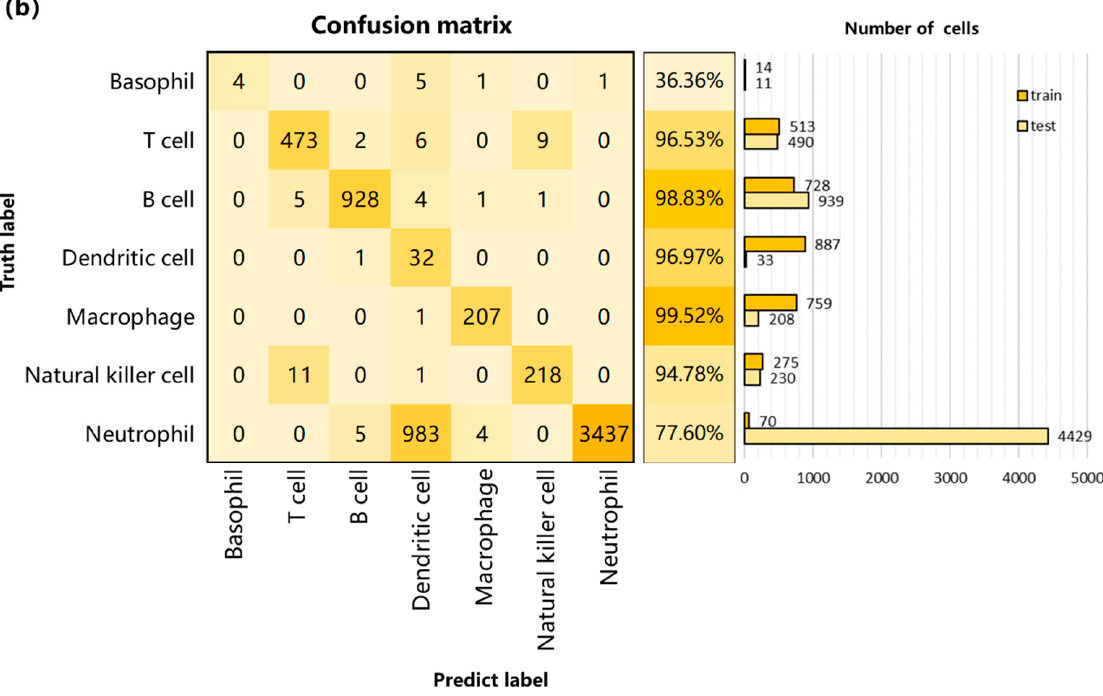
Figure 6. Confusion matrix of prediction results on external test datasets. ( a ) Confusion matrix for predicting results on the human lung dataset; ( b ) Confusion matrix for predicting results on the mouse lung dataset. The accuracies in the graphs represent the accuracies of the predicted results for each cell label. The bars represent the number of training cell samples and the number of test cell samples for each cell